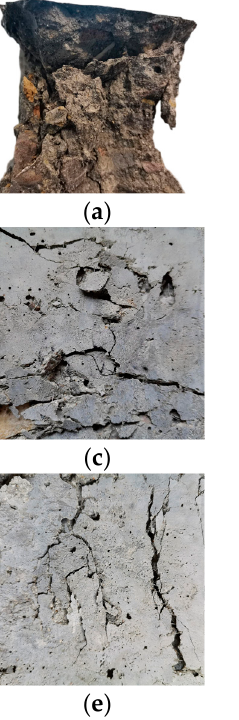
Figure 8. Compressive failure pictures of PRGRC with different fiber volume contents under 100 freeze-thaw cycles: ( a ) 0%; ( b ) 0.25%; ( c ) 0.50%; ( d ) 0.75%; ( e ) 1.00%.